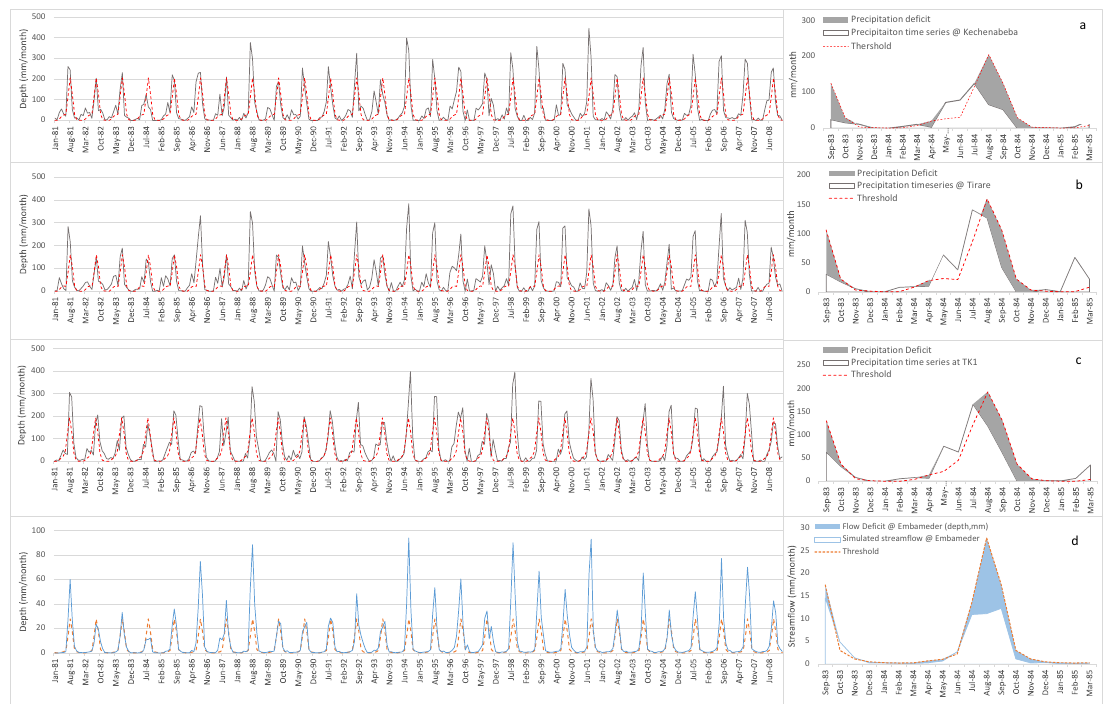
Figure 6. Left: Monthly precipitation ( a ) at Kechenabeba sub-basin, ( b ) at Tirare sub-basin, and ( c ) at Tekeze TK1 sub-basin and simulated streamflow (( d ) at Embameder station) with corresponding 80% thresholds. Right: Illustrating monthly drought propagation in the year 1984. The shaded region (in grey for precipitation and blue for streamflow) shows the